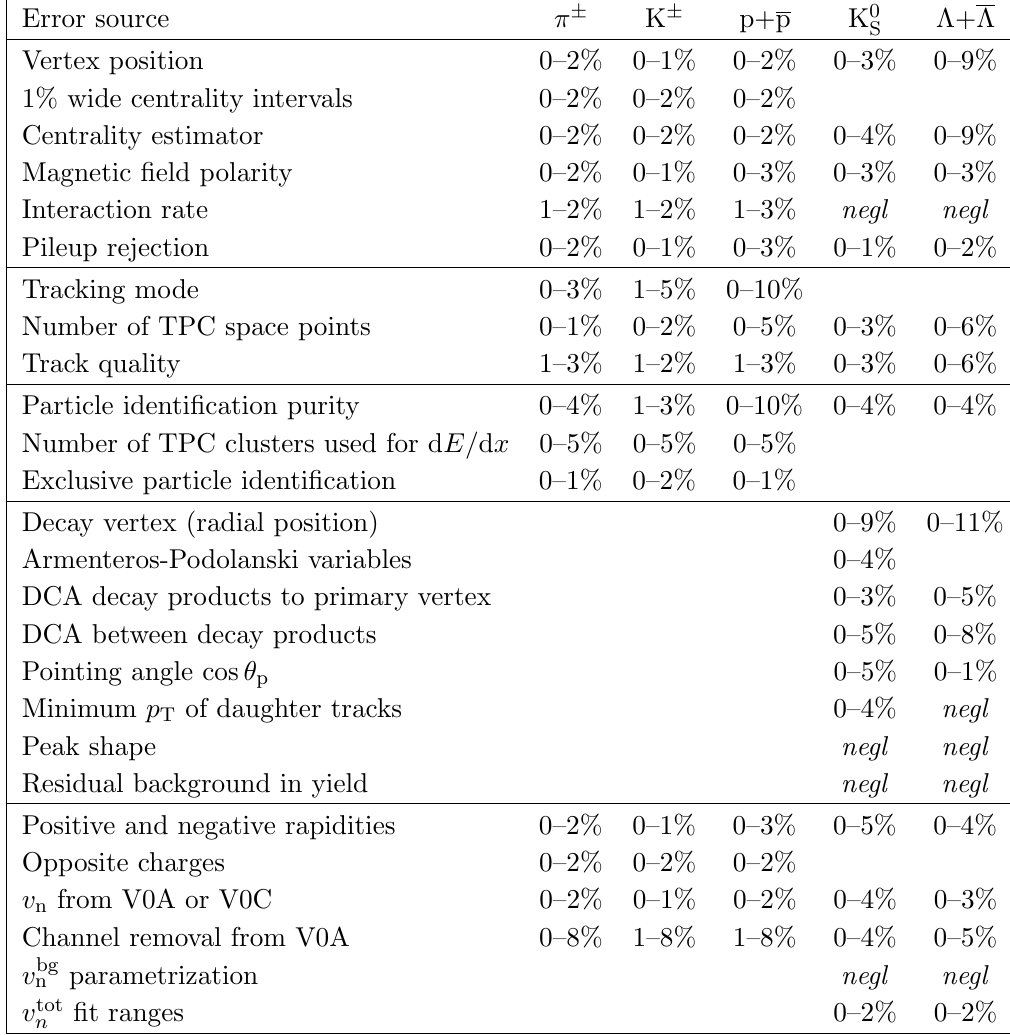
Table 2 . Summary of systematic uncertainties for the v 3 of (cid:25) (cid:6) , K (cid:6) , p+p, (cid:3)+(cid:3), and K 0 uncertainties depend on p T and centrality range; minimum and maximum values are listed here. Empty (cid:12)elds indicate that a given check does not apply to the particle of interest. If an uncertainty has been tested but cannot be resolved within statistical precision, the (cid:12)eld is marked negl for negligible. Horizontal lines are used to separate the di(cid:11)erent categories of systematic uncertainties as explained in section